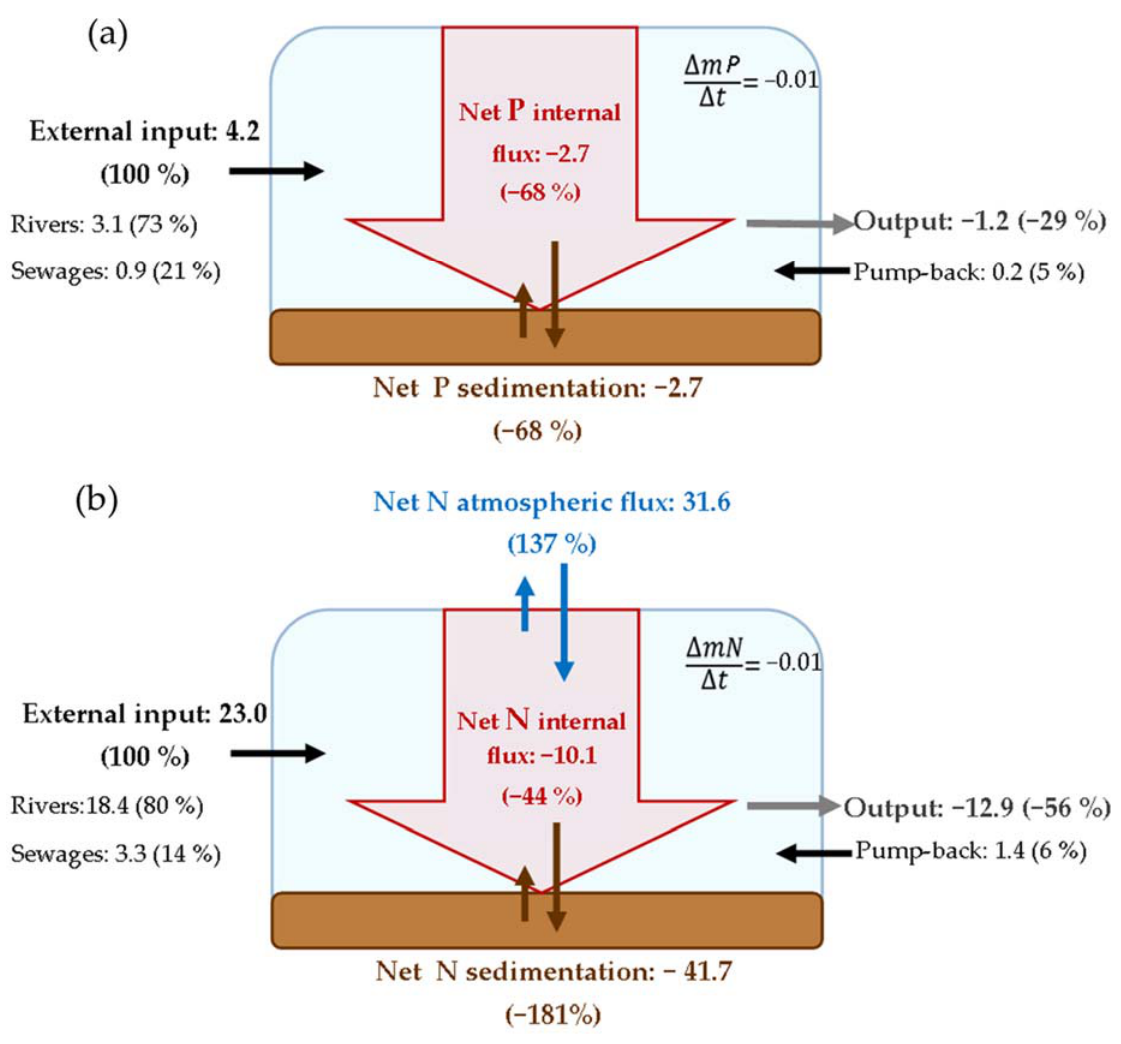
Figure 8. Graphical summary of the mean annual: ( a ) P and ( b ) N fluxes (g N m − 2 y − 1 ) in the VB reservoir for the period 2003–2018. The percentage of each flux relative to the total annual load of each element through water sources (rivers and sewages) is shown in parenthesis.